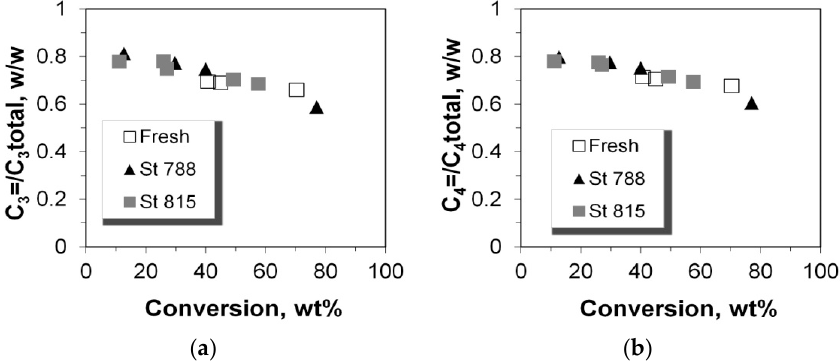
Figure 13. Olefinicity ratios for LPG range products: ( a ) C 3 ; ( b ) C 4 .